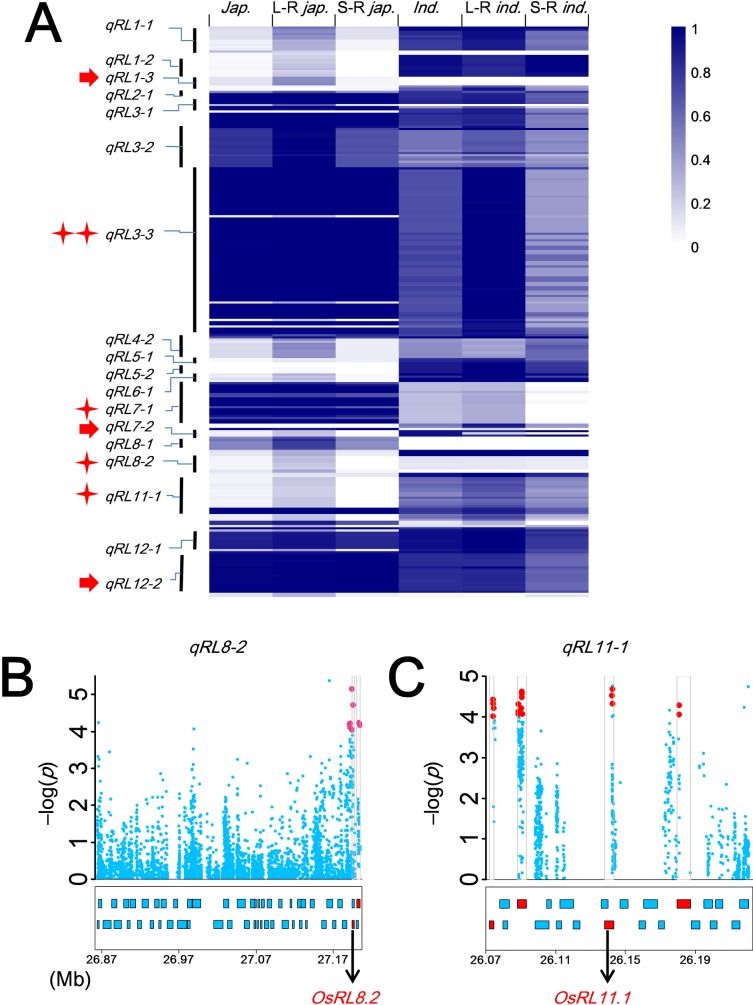
Determination of candidate genes for root-length QTLs by integrated analyses of GWAS, linkage mapping and pooled-χ2-tests.(A) Heat map showing significant differences in long-root allele frequencies at 230 SNPs in 85 genes in 18 GWAS detected root-length QTL regions of the two extreme phenotypic pools (long-root vs short-root varietal pools) within rice populations (S1 Table), in which different colors show different long-root allele frequencies; rows of the heat map are SNP sites and QTLs; columns are long-root allele frequencies in different populations (japonica, long-root japonica, short-root japonica, indica, long-root indica and short-root indica); red arrows and stars show QTLs with known genes and candidate genes identified and confirmed for root length in this study. Identification of candidate genes in regions of (B) qRL8-2 and (C) qRL11-1. The top of each panel shows the entire QTL region identified by GWAS using the whole population and CMLM, and X-axis indicates the physical position (Mb) of the QTL regions in the rice genome. Negative log10-transformed P values are plotted on the vertical axis, in which dots show positions and -log(P) values of all significant SNPs in the QTL region and the red points indicate SNPs with significant differences in allele frequency of GWAS detected QTLs between the root-length pools and differential alleles between parents in previously reported bi-parental mapping populations; pink points represent SNPs with significant differences in allele frequency between pools, when the QTL was mapped only in our GWAS; and skyblue points show others. At the bottom of each panel, annotated genes are indicated by skyblue boxes; candidate genes are colored in red. Functional genes verified are red-labeled.